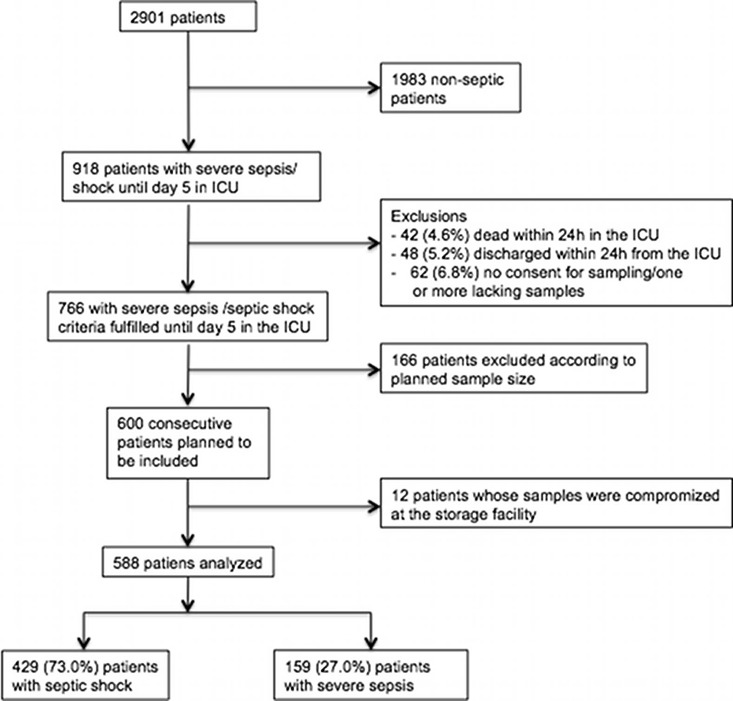
Study flow chart ICU; intensive care unit.